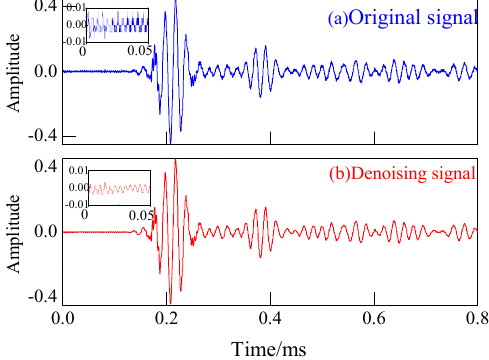
Figure 8. The original signal and denoising signal.